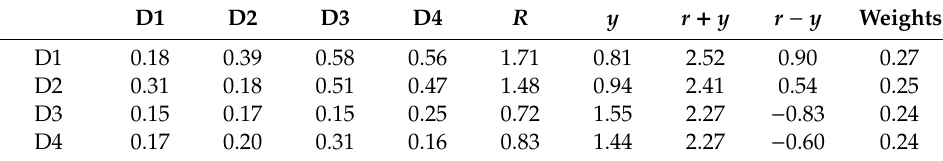
Table A6. Defuzzified total relation matrix and the weights for the dimensions.